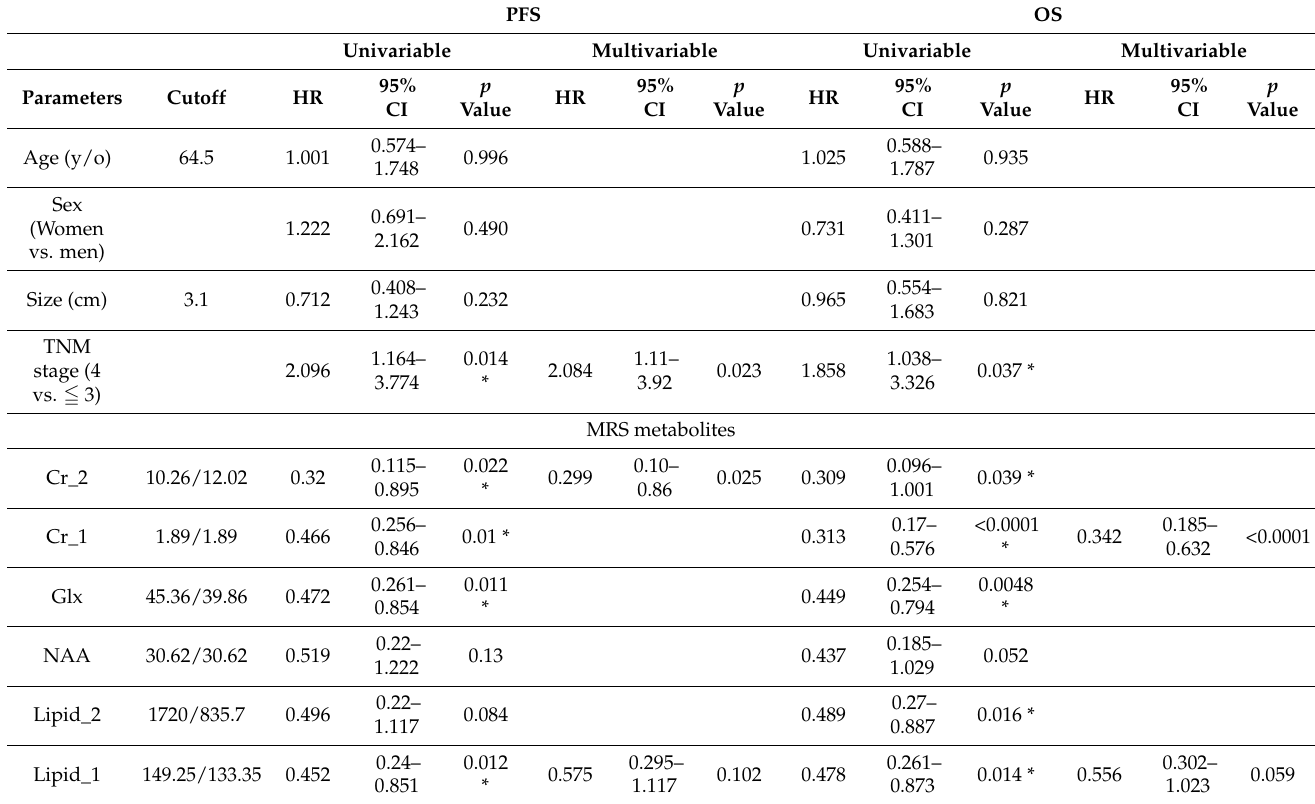
Table 4. Univariable analysis of prognostic factors for PFS and